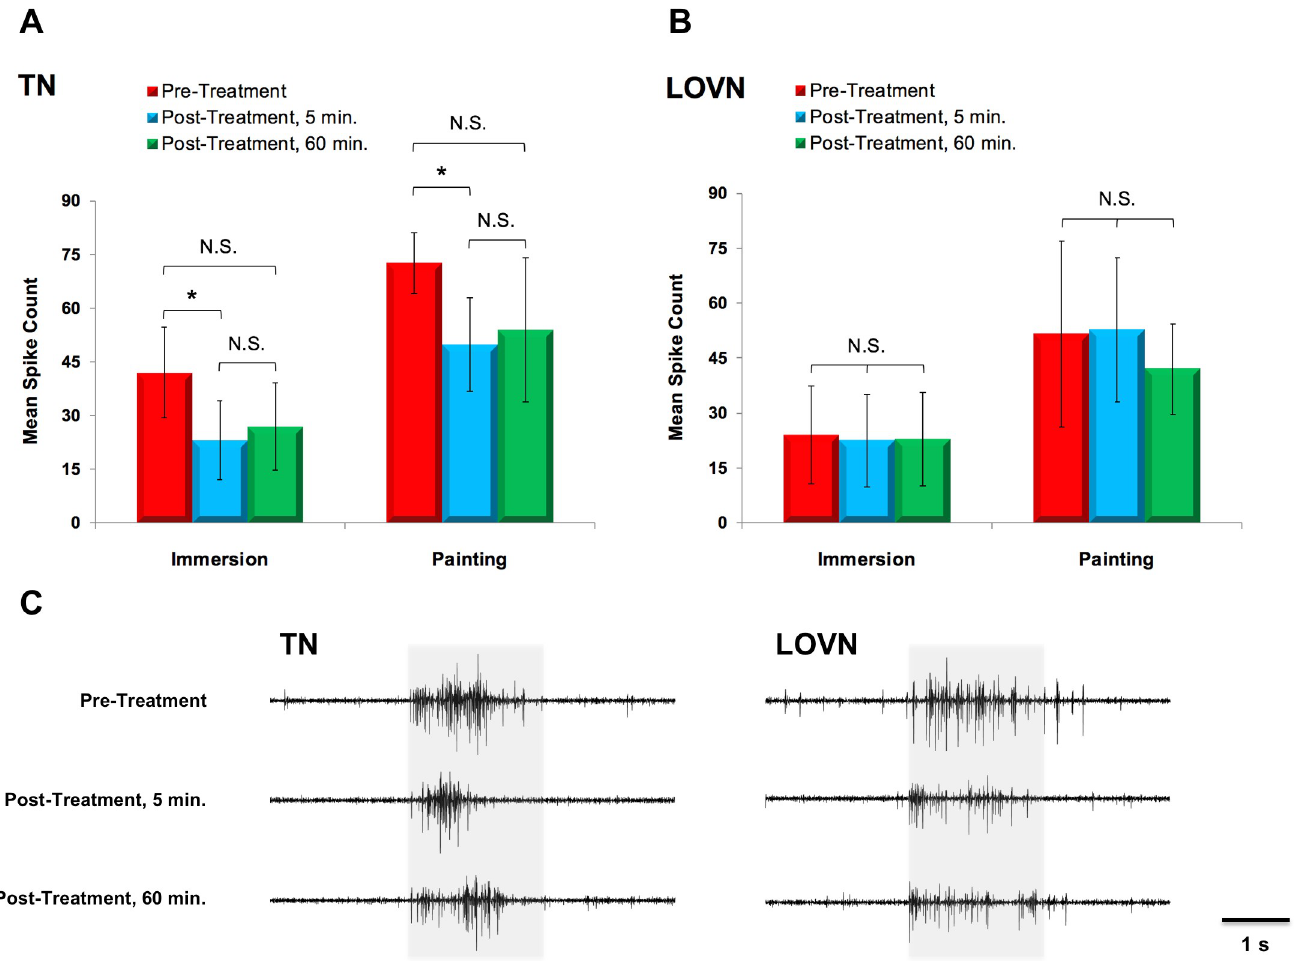
Fig 9. The D 2 /D 3 dopaminergic antagonist sulpiride significantly reduced sensory responses to tactile stimuli measured in the tentacle nerve (TN). (A) Stimulus-evoked activity in the TN was attenuated by treating the OVTC with sulpiride, both through immersion (weighted-means one-way repeated measures ANOVA, F (2,18) = 5.75, p = 0.0117) and painting ( F (2,9) = 4.98, p = 0.0350). When measured at 5 minutes following sulpiride treatment, TN activity had decreased by 18.81 ± 16.81 (mean ± SEM; Tukey’s test, p = 0.0130) in immersed preparations and by 22.85 ± 15.68 spikes ( p = 0.0288) in preparations that had been